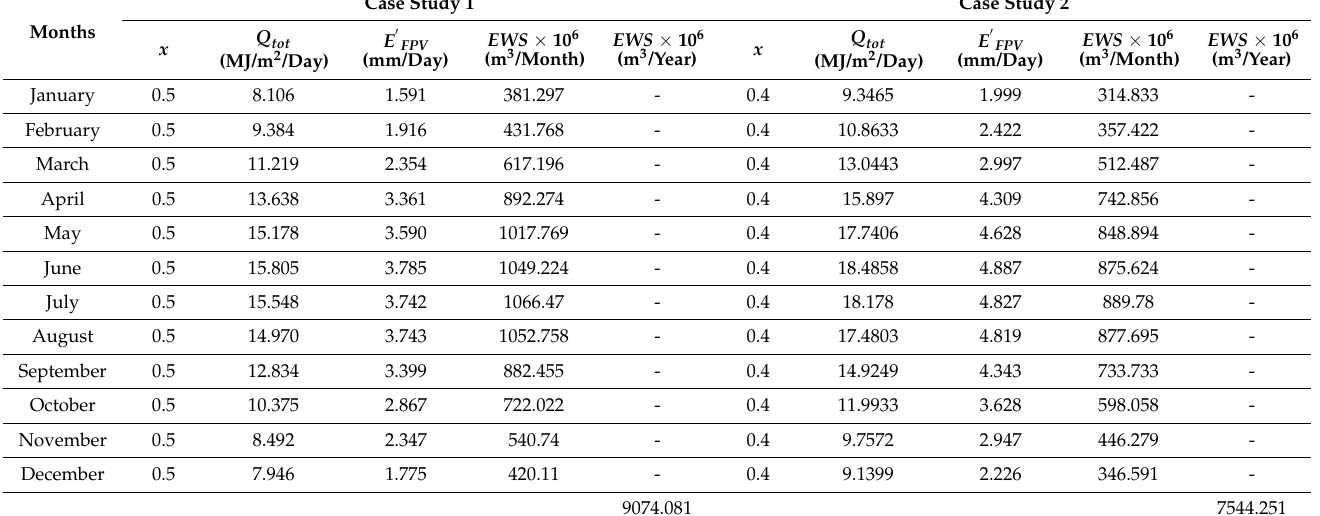
Table 2. Water evaporation savings results (Case Study 1 and Case Study